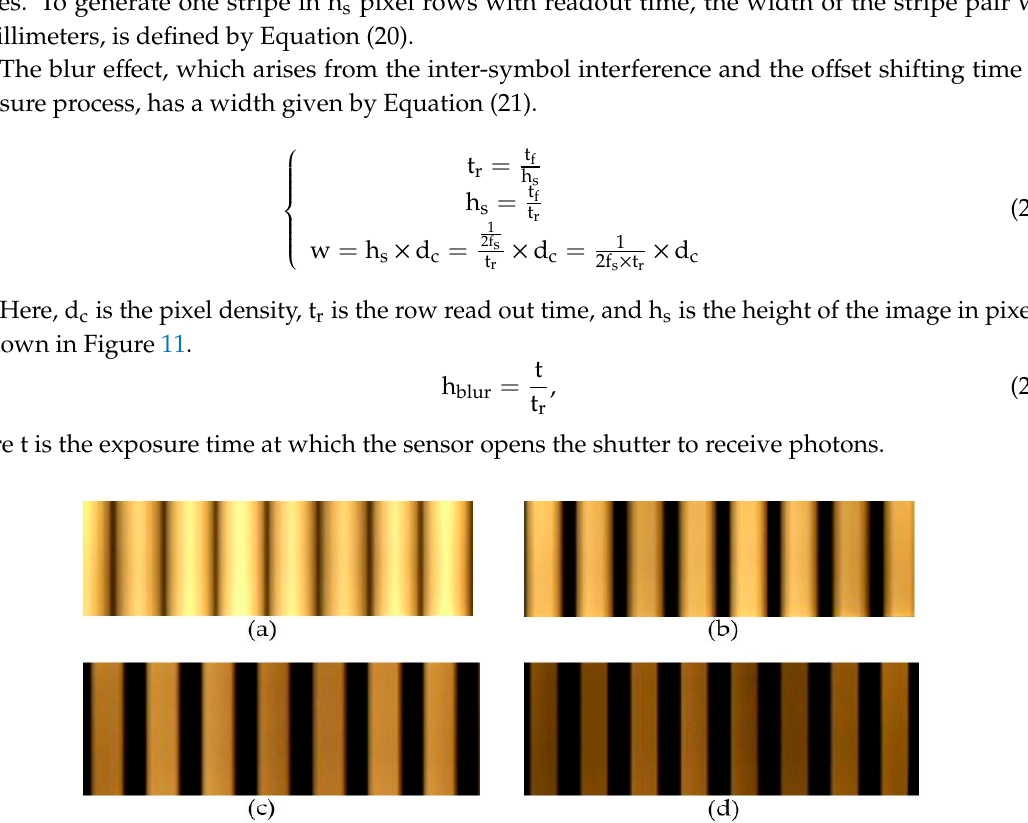
Figure 11. Effect of shutter speed in the received image. ( a ) 1000 Hz of shutter speed. ( b ) 2000 Hz of shutter speed. ( c ) 4000 Hz of shutter speed. ( d ) 8000 Hz of shutter speed.